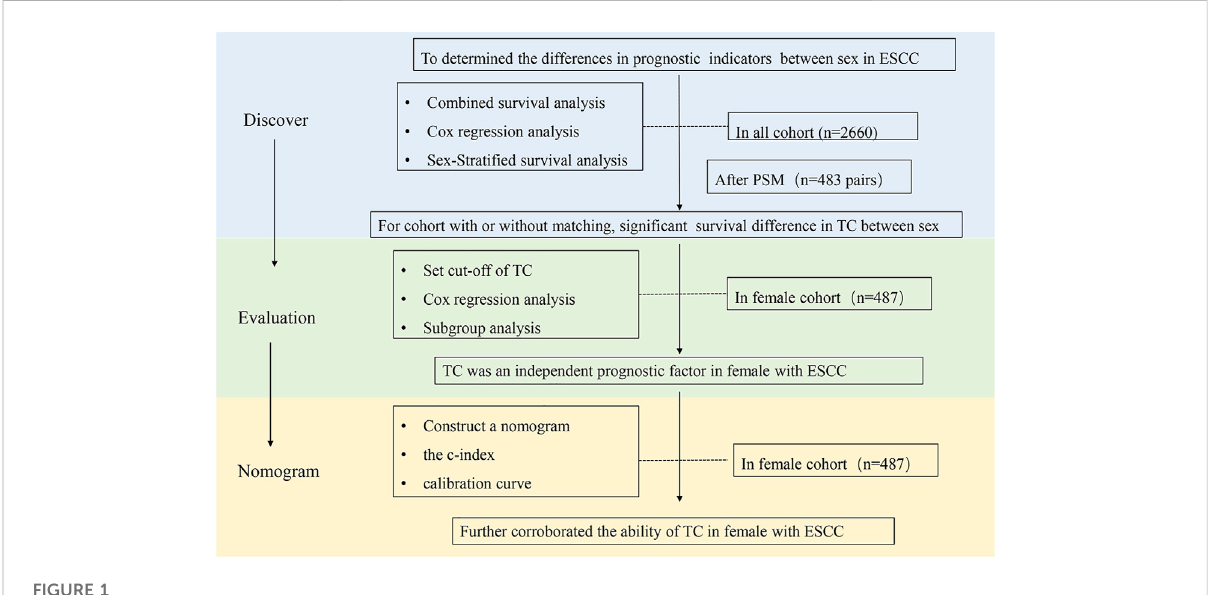
FIGURE 1 The fl ow chart of this